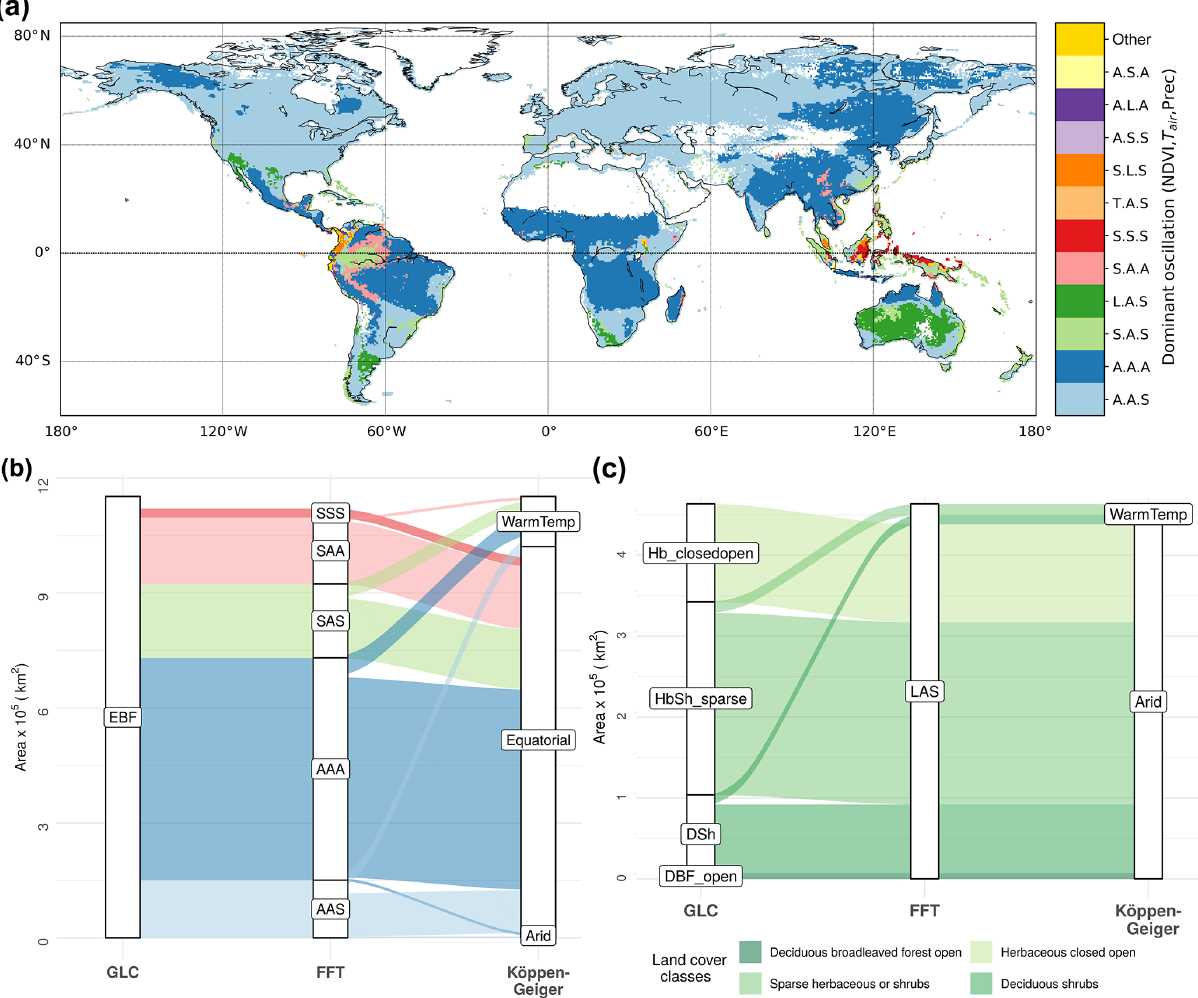
Figure 2. Classification of land surface by dominant scale of variability in NDVI and climate, and its relation to land cover and mean climate. (a) Dominant scale of variability was determined for NDVI, T air , and Prec separately for each grid cell and summarized as unique combinations between variables (S – short term, A – seasonal, L – longer term, T – trend, listed in the order of NDVI, T air , and Prec). Only the 11 most common classes are shown. The semiannual cycle is included in the seasonal band. (b, c) Sankey diagrams (river plots) showing associations of pixels for (b) evergreen broadleaf forest (EBF) and (c) regions of dominant long-term oscillations in NDVI (LAS class) to oscillation regime (FFT), land cover class (GLC2000), and Köppen–Geiger (KG) climate class. The width of the ribbons is proportional to the area that is commonly classified into the corresponding GLC2000, KG, or oscillation classes. DBF: deciduous broadleaf forest; Hb_closedopen: herbaceous closed open land cover; DSh: deciduous shrublands; HbSh_sparse: sparse herbaceous and shrub vegetation; Equatorial: KG class A; Arid: KG class B; WarmTemp: KG class C; NDVI: normalized difference vegetation index; T air : air temperature; Prec: